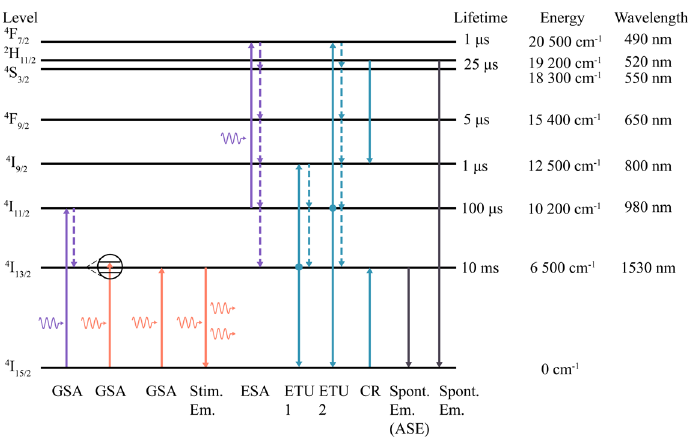
Figure 1. The energy-level model of Er 3+ .